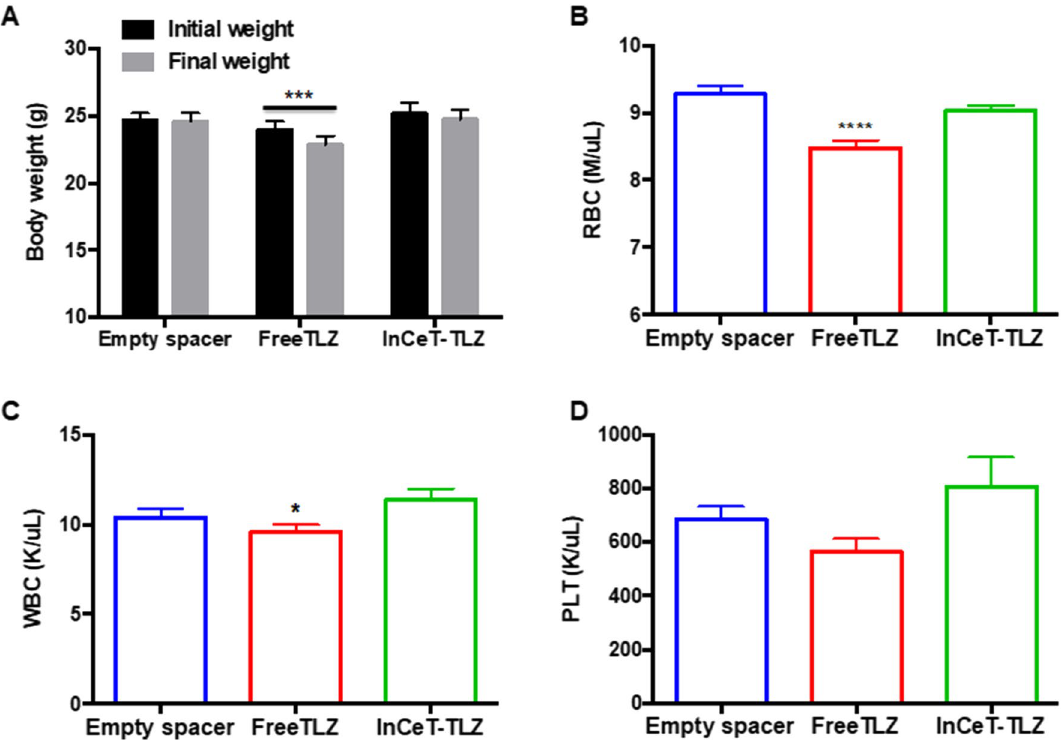
Figure. 4. InCeT-TLZ is better tolerated than oral TLZ treatment. ( A ) Body weight of mice before initiation and at the end of treatment. N = 33–35 mice/group. ***p < 0.001 vs. initial weight. ( B ) Red blood cell count ( B ), white blood cell count ( C ) or platelet count ( D ) after 4 weeks of treatment; N = 33 mice/group. ****p < 0.0001 vs. empty spacer; *p < 0.05 vs.